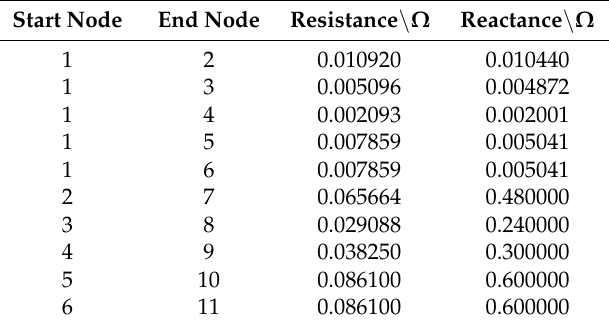
Table A1. Parameters of distribution